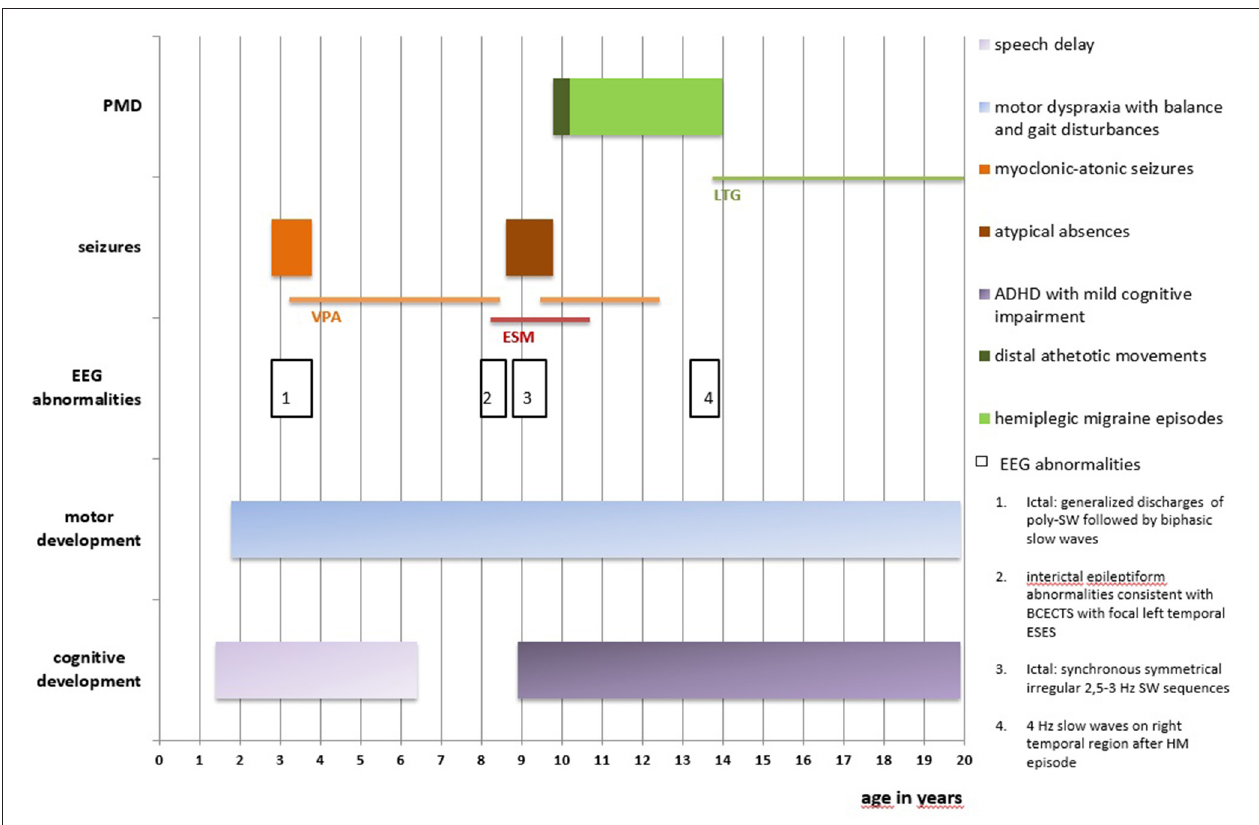
FIGURE 1 | Clinical history is summarized in this figure. PMD, paroxysmal movement disorders; EEG, electroencephalography; BCECTS, Benign Childhood Epilepsy with Centro-Temporal Spikes; ESES, Electrical Status-Epilepticus during slow-waves Sleep; SW, spike-and-wave; poly-SW, polyspike-and-wave; HM, hemiplegic migraine; ADHFD, Attention Deficit and Hyperactivity Disorder; VPA, Sodium Valproate; ESM, Ethosuximide; LTG,